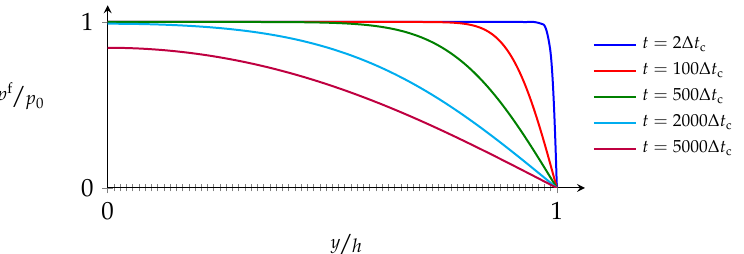
Figure 4. Numerical solution to the Terzhagi problem with p p = 1, p u = 2 and and N e = 72 using critical time